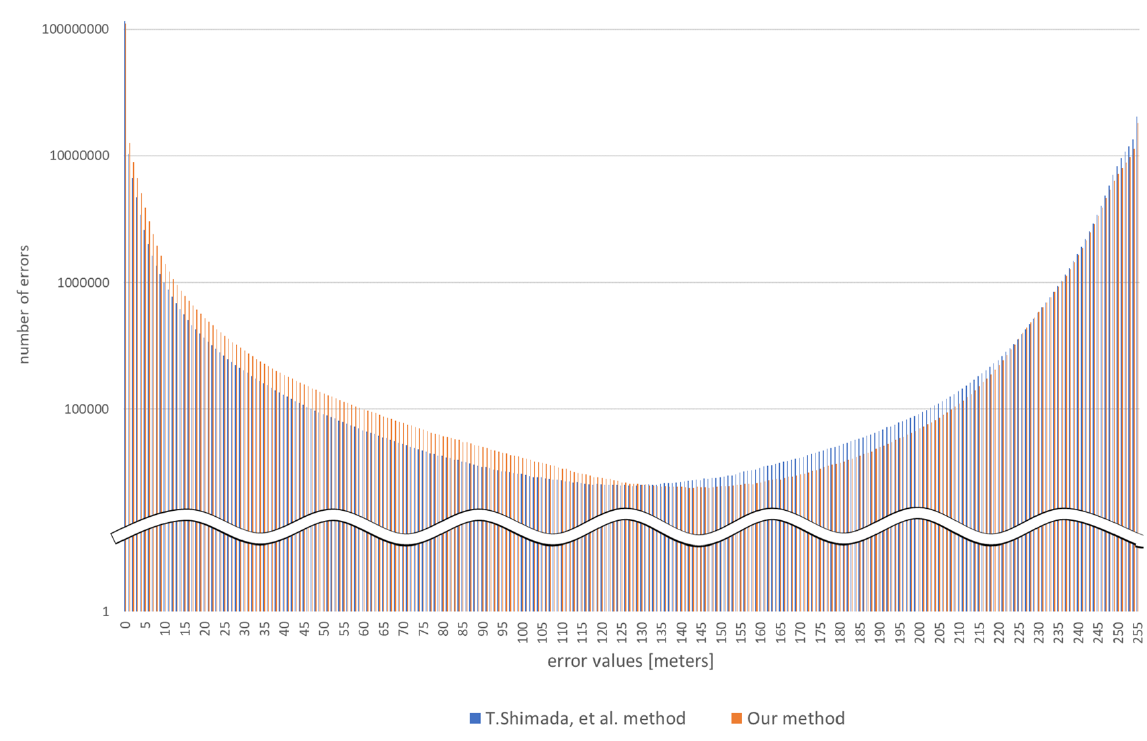
Figure 14. Error